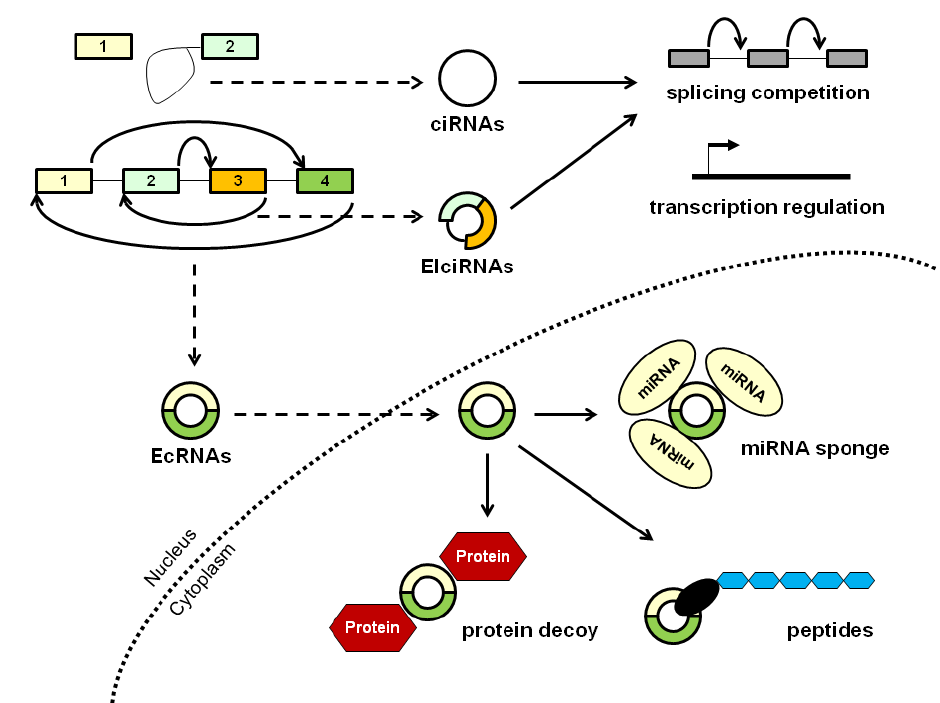
Figure 1. Biogenesis and molecular functions of circular RNAs (circRNAs).